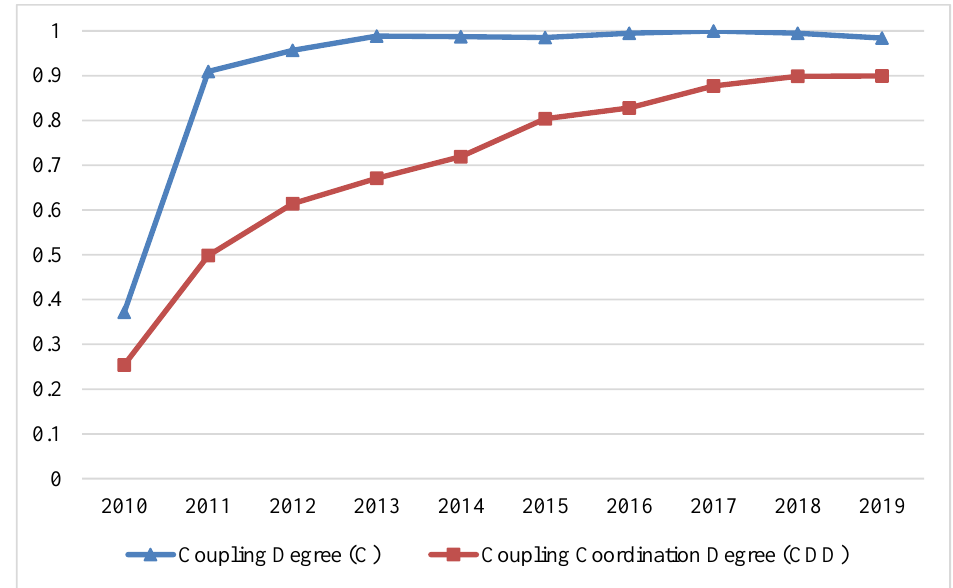
Figure 11. The C and CCD of the TEE system in the PRD.